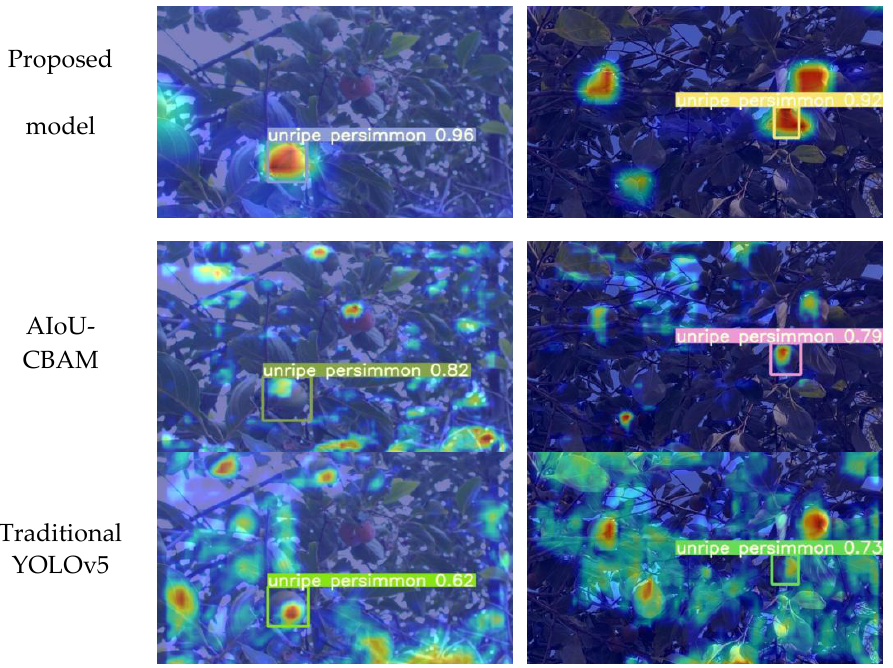
Figure 13. Visualization of the thermal map of the YOLOv5 partial structural layer.